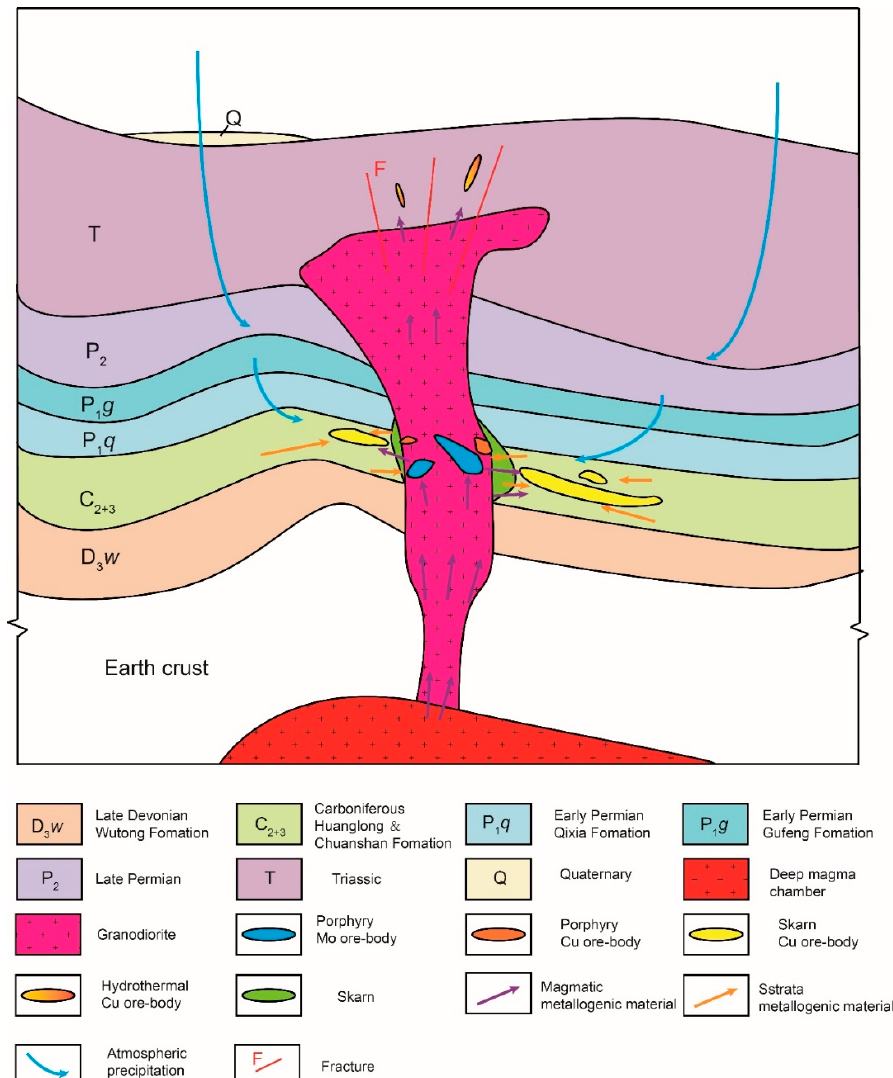
Figure 17. Metallogenic model map of the Hucunnan Cu–Mo deposit.